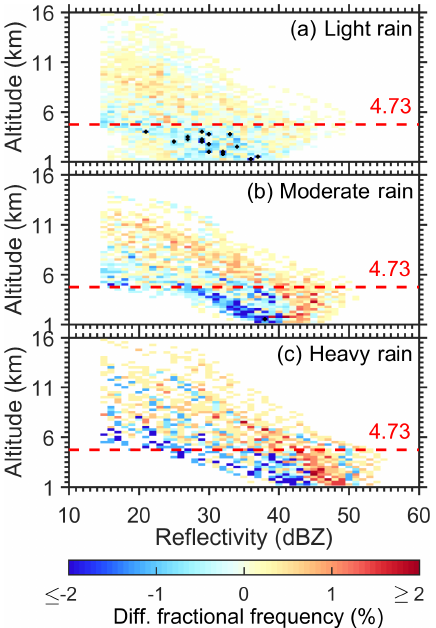
Figure 5. The differences of normalized contoured frequency by altitude diagram ( (cid:49) NCFAD) showing the differences in occur- rence frequency for detected rain echoes (polluted minus clean) for (a) shallow, (b) stratiform, and (c) convective regimes. Data are from TRMM PR retrievals made during 2007–2012. The horizontal red dashed lines show the freezing level and the black crosses mark grid points where the difference exceeds the 95% significance level ( p <0.05) according to the Pearson’s χ 2 test.